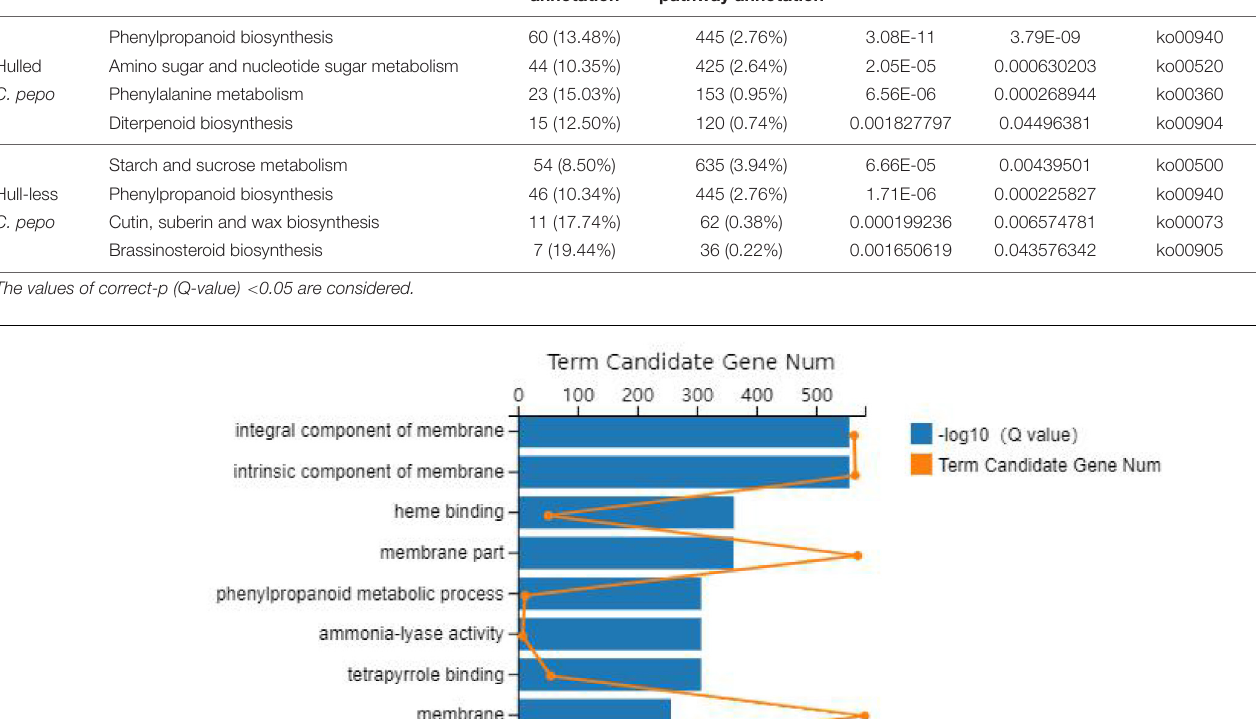
According to the FPKM value of the above genes and the Fold change differential expression in the seed coat of CP and HLCP varieties, it can be considered that these genes were closely related to the formation of seed